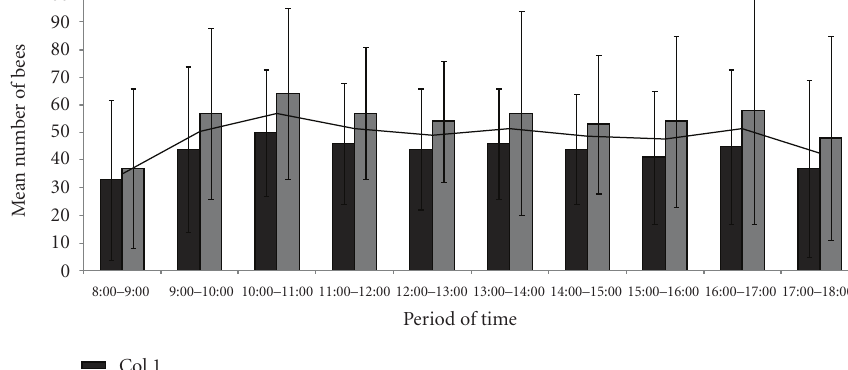
between the total number of bees collecting nectar in the reproductive phase and in the diapause (Wilcoxon sign-rank test, colony 1: P > . 05; colony 2: P > .